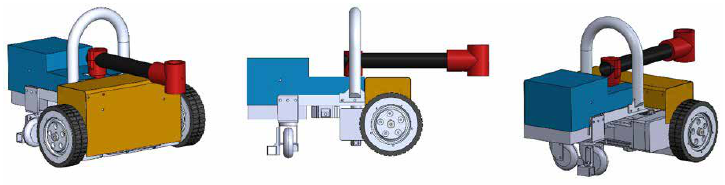
Figure 5. Hornbill Design.